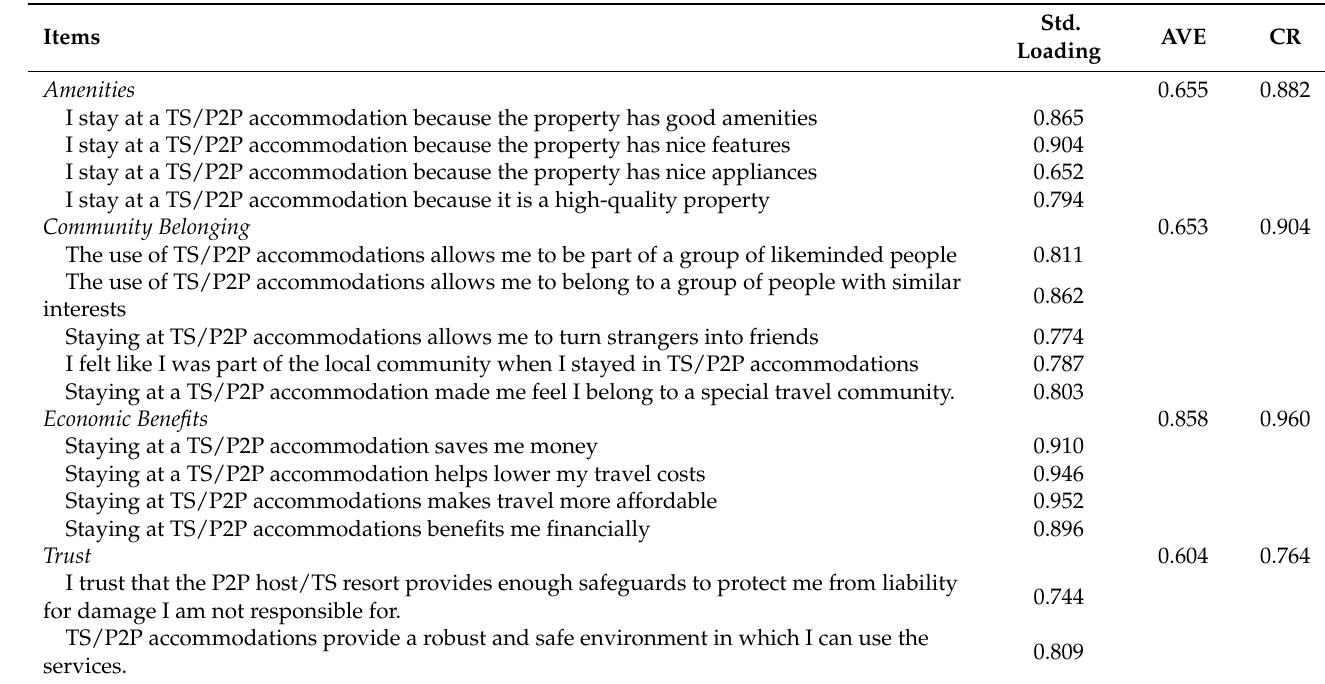
Table 3. Convergent validity